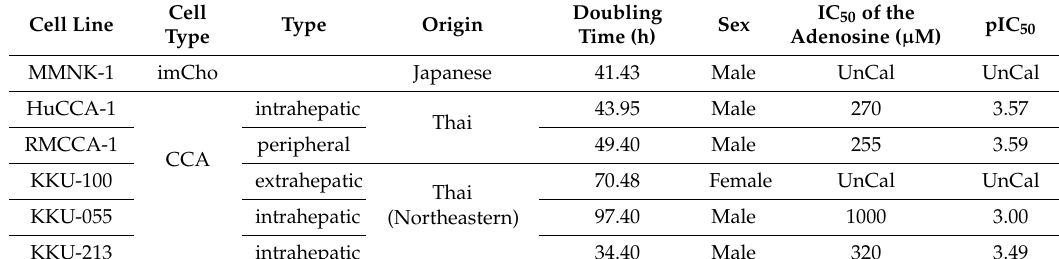
Table 1. IC 50 and pIC 50 of the adenosine on cholangiocarcinoma (CCA) and immortalized cholangiocyte (imCho) cell lines. UnCal; uncalculatable.